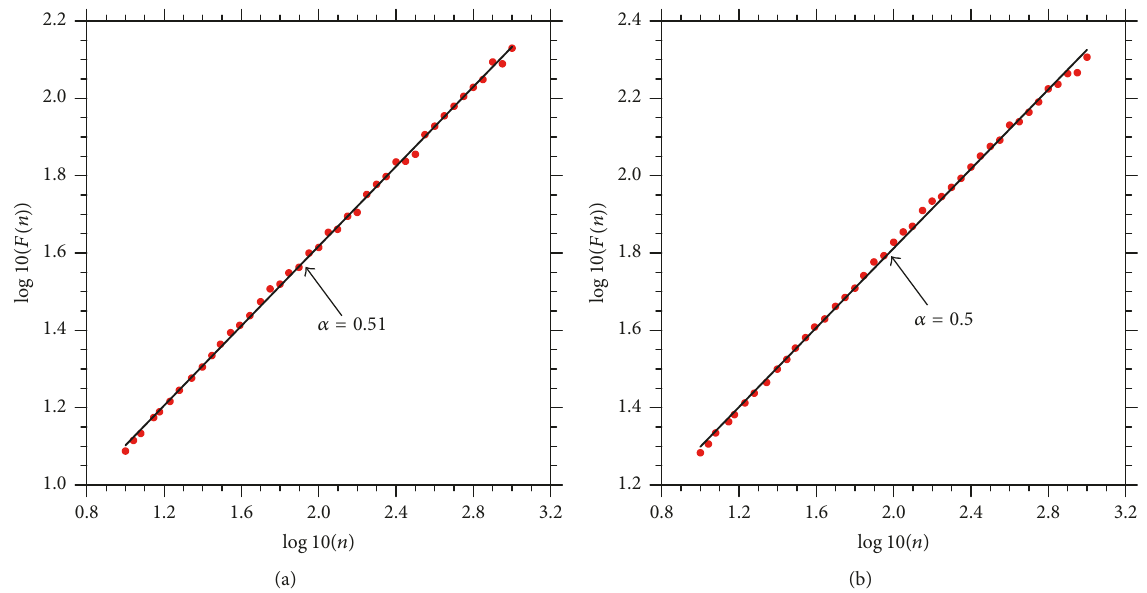
Figure 3: The double log plots of the power-law relationship between the detrended variability 𝐹(𝑛) and the time scale 𝑛 for randomly shuffled OLR of the two grid points (95 ∘ E, 35 ∘ N) and (97.5 ∘ E, 12.5 ∘ N). The black solid lines are linear fit. (a) is for the grid point (95 ∘ E, 35 ∘ N) and (b) is for the grid point (97.5 ∘ E, 12.5 ∘ N).